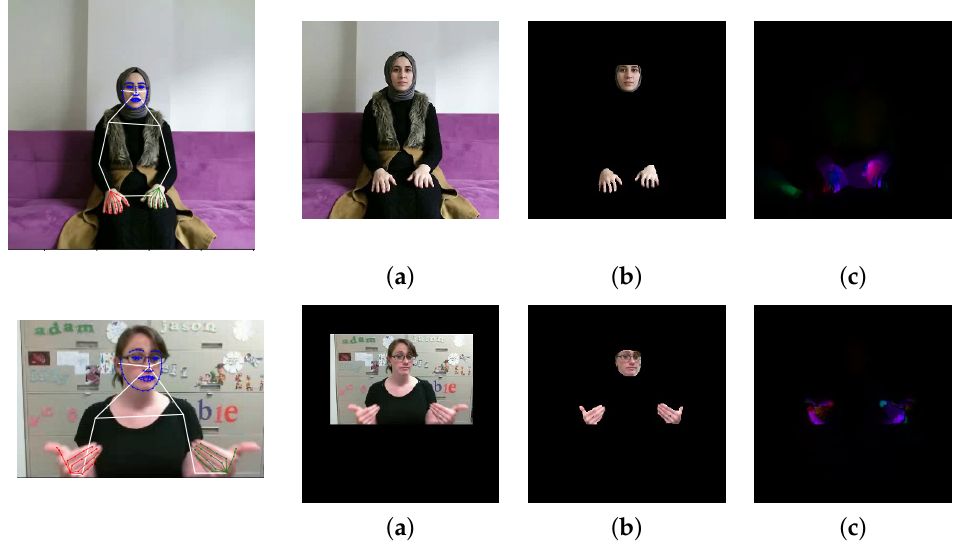
Figure 1. The first line: AUTSL dataset, the second line: WLASL300 dataset. On the left: Positions of joints and salient points on the face in a source RGB video frame of a given size, on the right: Data normalization and preprocessing ( a ) Crop&Resize data variant, ( b ) the Masked data variant, and ( c ) the OptFlow data